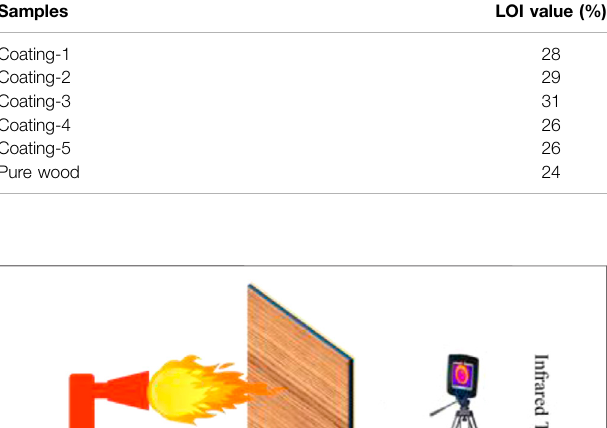
TABLE 3 | LOI value of different coatings. Samples